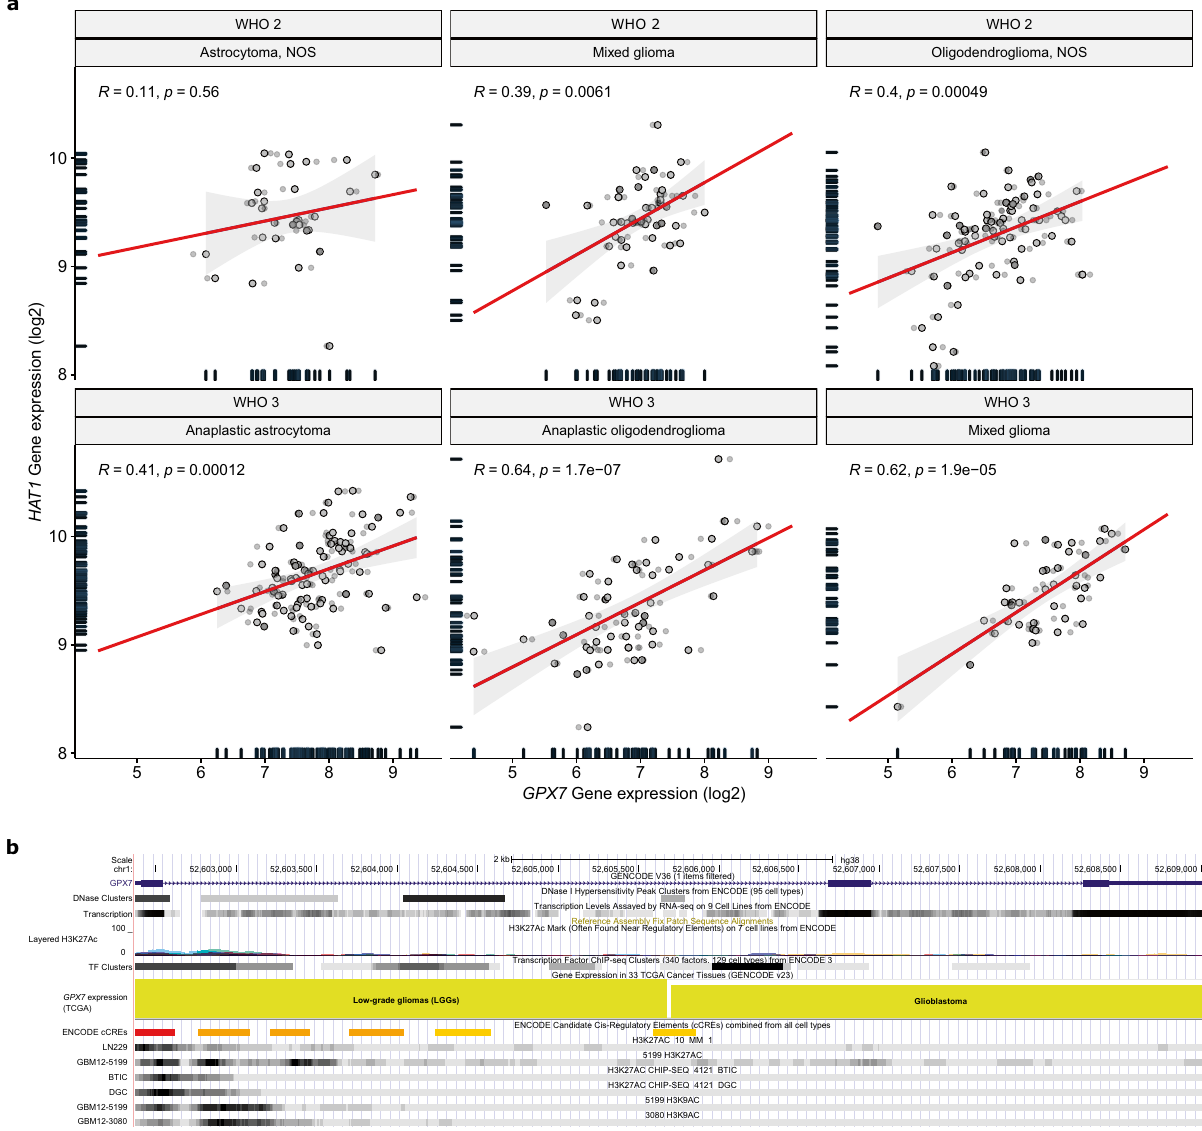
Figure 6. H3K9ac and H3K27ac marks can alter GPX7 expression. ( a ) Correlation between GPX7 and HAT1 expression according to WHO grades (2 and 3) and histology of TCGA-LGG tumors. NOS: Not Otherwise Specified. ( b ) Representative UCSC genome browser view of GPX7 genomic region showing chromatin immunoprecipitation (ChIP) enrichment for H3K9ac and H3K27ac (active chromatin marks) using ChIP-seq data from LN229 (GBM cell line) (GSE109340), GBM12-5199 (PDX model of GBM) 89 , GBM12-3080 (PDX model of GBM) 89 , GBM12-5199 (PDX model of GBM) 89 , GBM12-3080 (PDX model of GBM) 89 , Brain tumor initiating cells (BTICs) 90 , differentiated glioma cells (DGCs) 90 . DNase clusters: shows chromatin accessibility following binding of trans-acting factors in place of a canonical nucleosome. The display for this track shows site location and signal value as grayscale-colored items where higher signal values correspond to darker-colored blocks. This track is a composite annotation track containing multiple subtracks, one for each cell type. Layered H3K27Ac: This track shows the enrichment levels of the H3K27Ac histone mark across the genome as determined by a ChIP-seq assay. Also, this mark is thought to enhance transcription, possibly by blocking the spread of the repressive histone mark H3K27Me3. GPX7 expression (TCGA): shows RNA expression level for each TCGA tumor (LGG and GBM) in GENCODE canonical genes. The gene scores are a total of all transcripts in that gene. TF Clusters: This track shows transcription factor (TF) binding sites derived from a large collection of ChIP-seq experiments. A gray box encloses each peak cluster of transcription factor occupancy. The darkness of the box is proportional to the maximum signal strength observed in any cell type contributing to the cluster. ENCODE cCRES track: This track displays the ENCODE Registry of candidate cis- Regulatory Elements (cCREs) in the mouse genome. cCREs are the subset of representative DNase hypersensitive sites across ENCODE samples supported by either histone modifications (H3K4me3 and H3K27ac) or CTCF-binding data. CCREs are colored and labeled according to classification by regulatory signature: Red (promoter-like signature); orange (proximal enhancer-like signature); yellow (distal enhancer-like signature); pink (DNase-H3K4me3); blue